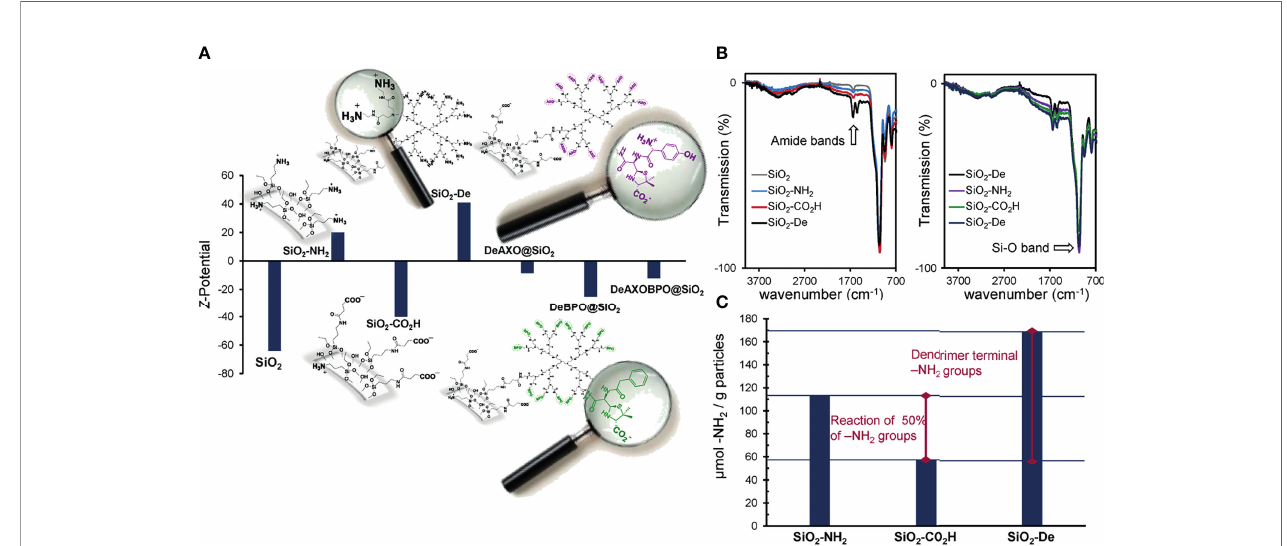
FIGURE 3 | (A) Z-potential measurements and (B) IR spectra of the functionalized particles; (C) quanti fi cation of free amino groups of SiO 2 -NH 2 , SiO 2 -CO 2 H and